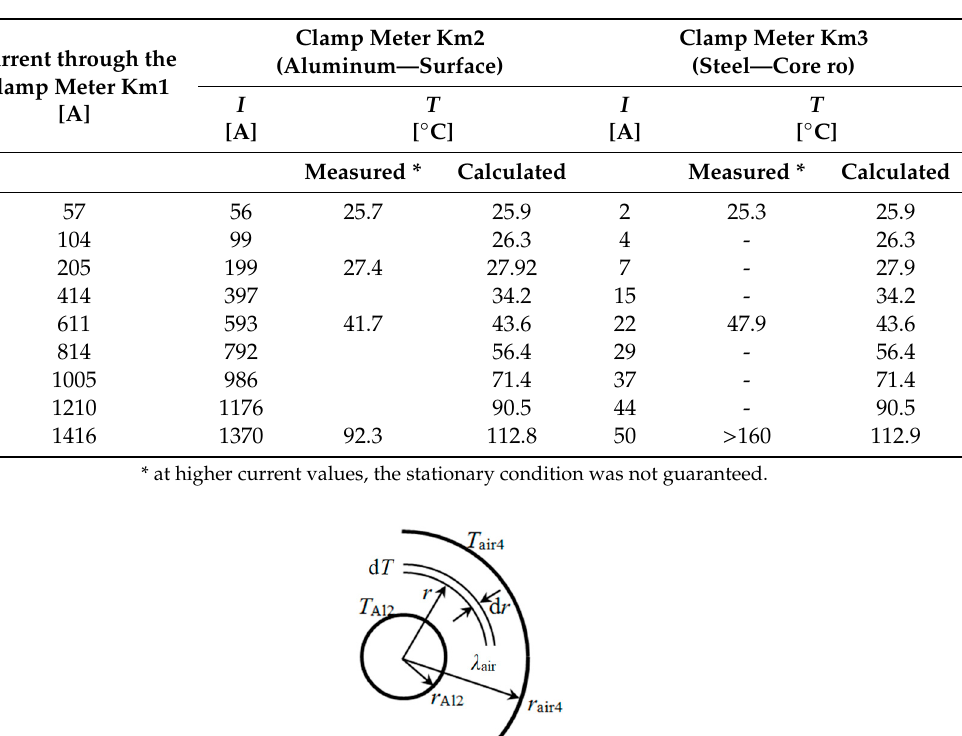
Table 4. Temperatures in dependency from radius and environmental